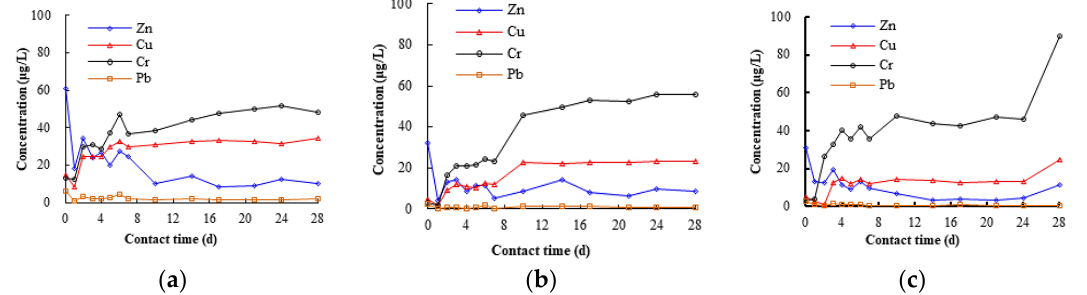
Figure 5. Variation of leaching concentrations of heavy metals with contact time for different MSWI-BAA particle sizes: ( a ) 0.075–2.36 mm; ( b ) 2.36–4.75 mm; ( c ) 4.75–9.5 mm.